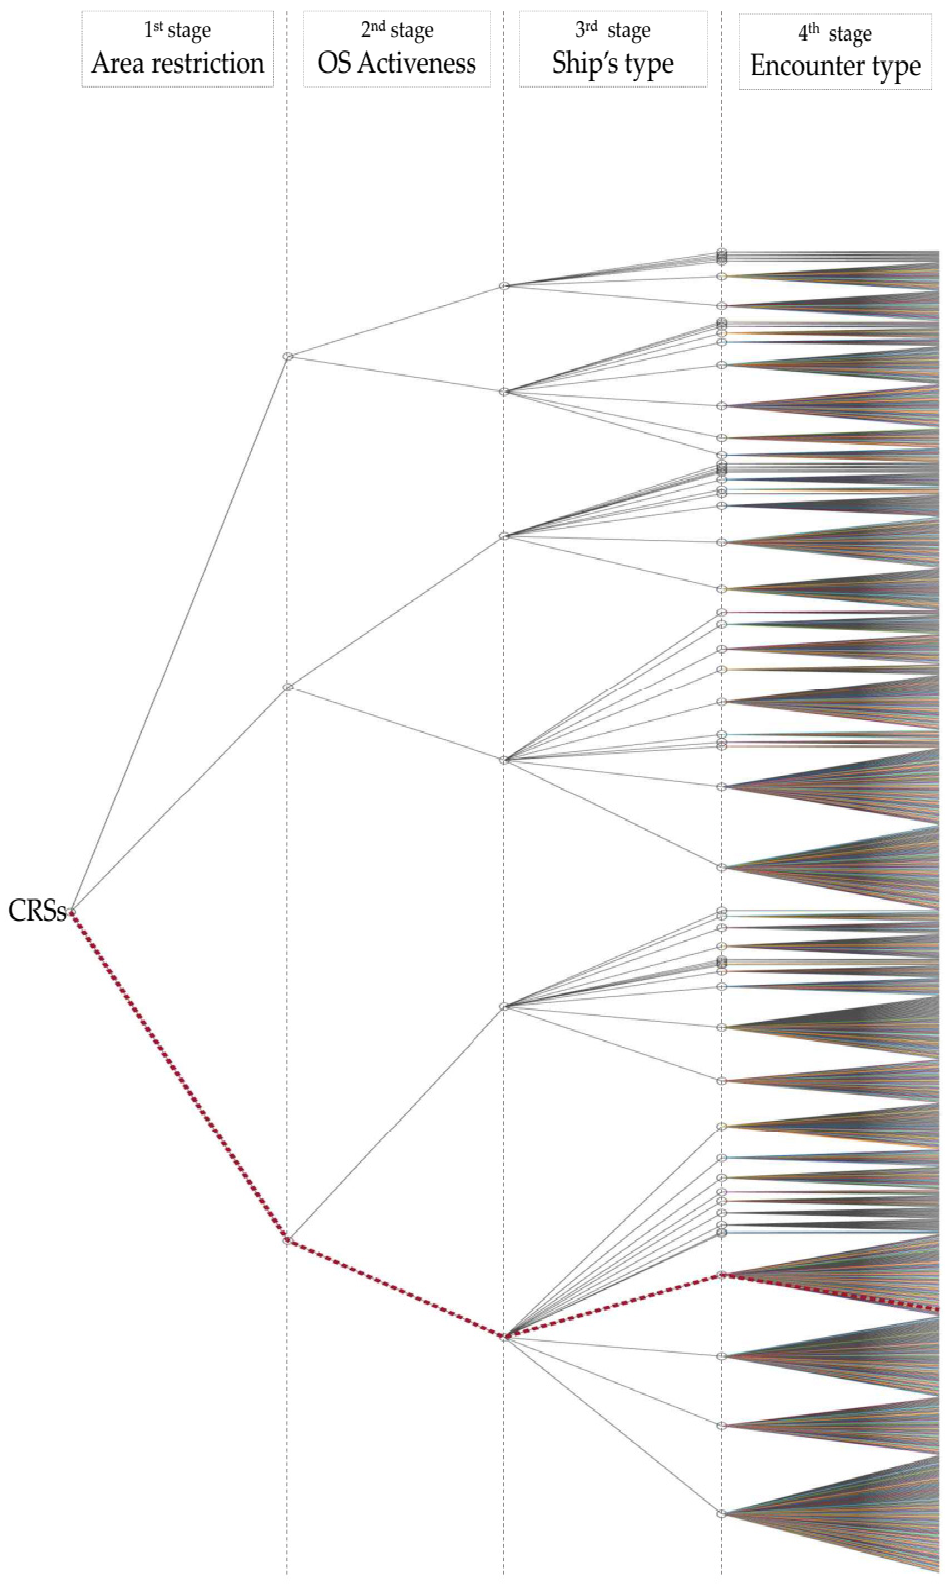
Figure 9. Topology of the clustering results. The red dotted line in Figure 9 is a sample CRS to explain the clustering result. As the line went through the clustering stages, CRSs were subdivided into detailed clusters.